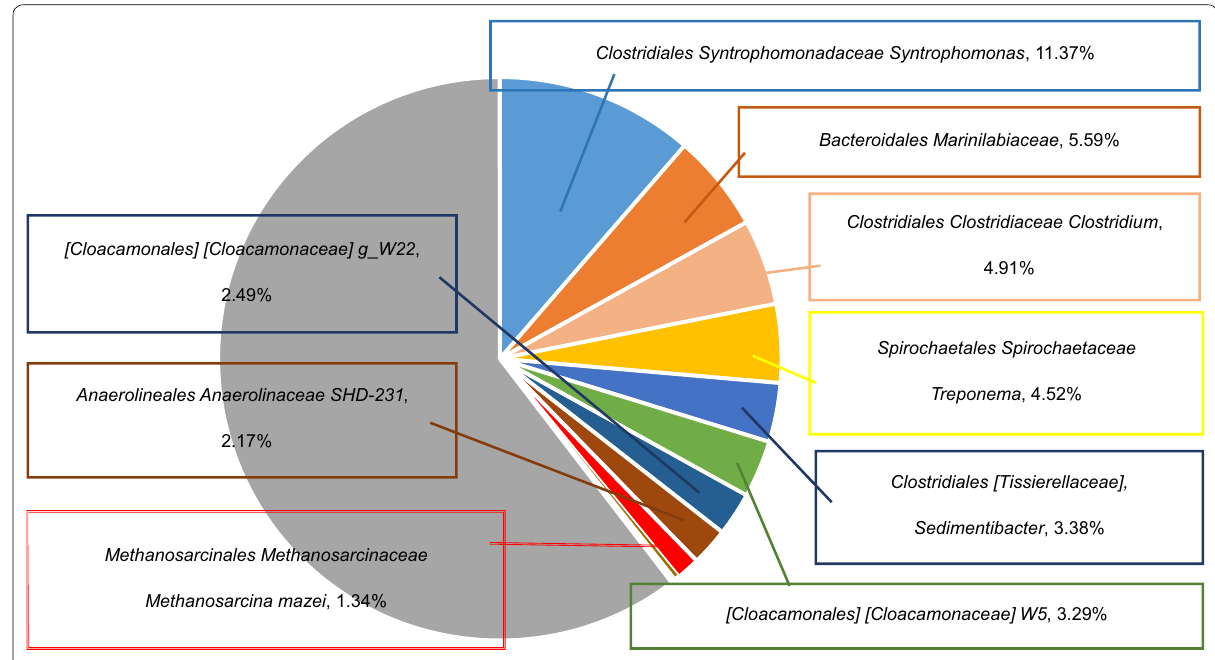
Fig. 3 Dominant families in MFMP by 16S rRNA